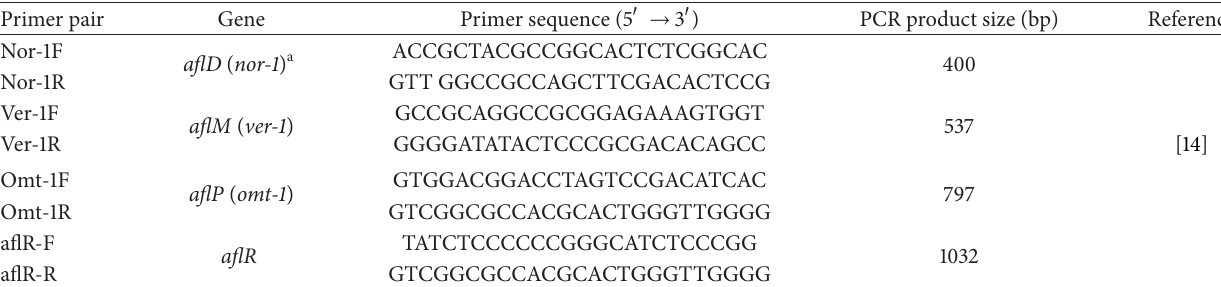
Table 1: Details of the target genes, primer sequences, and expected product length in base pairs (bp) for PCR. Primer pair